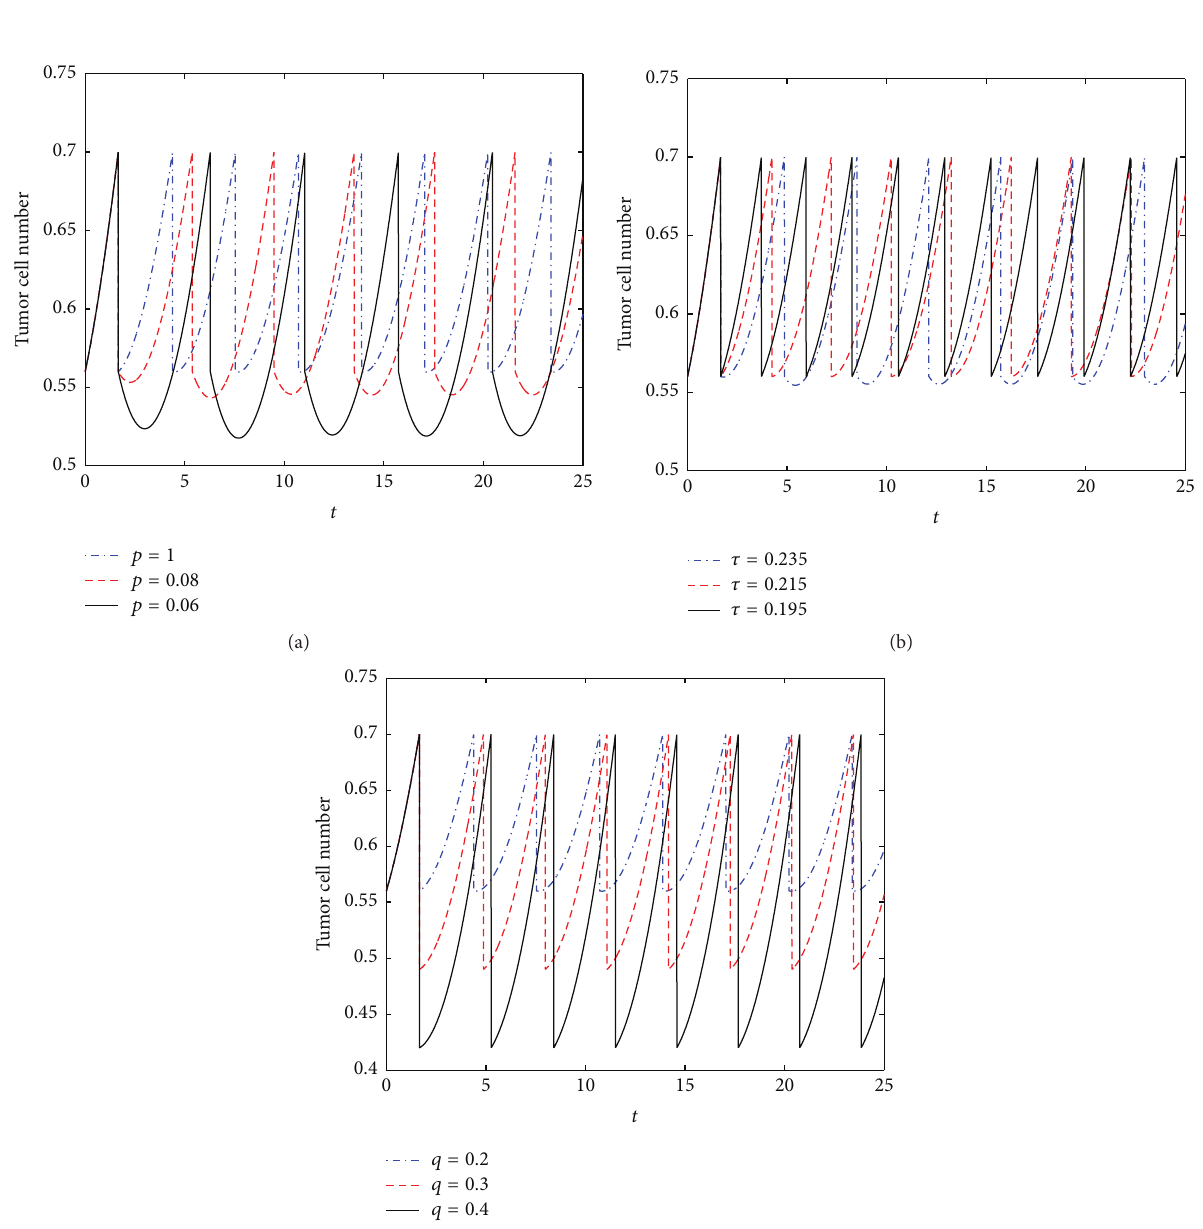
Figure 4: The effect of control parameters 𝑝 , 𝑞 , and 𝜏 for the dynamical behaviors of model (4): (a) 𝑝 = 0.1 , 0.08 , and 0.06 , respectively; (b) 𝜏 = 0.235 , 0.215 , and 0.195 , respectively; (c) 𝑞 = 0.2 , 0.3 , and 0.4 ,